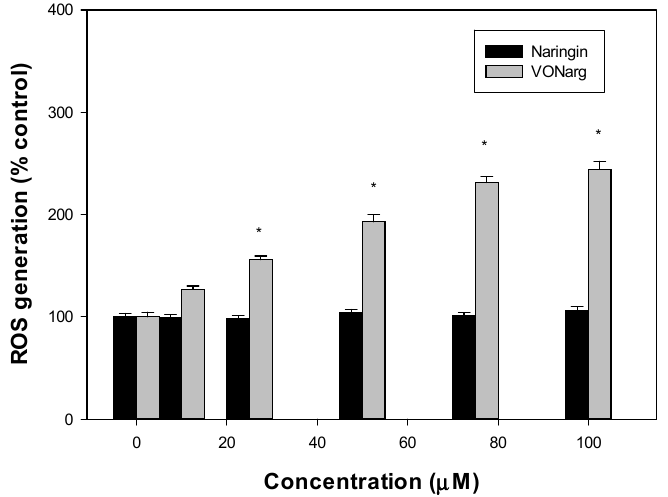
Figure 6. Effects of naringin (black) and VONarg (grey) on H 2 DCFDA oxidation to DCF. A549 cells were incubated at 37 °C in the presence of 10 μ M H 2 DCFDA. The values are expressed as the percentage of the control level and represent the mean ± SEM. * significant difference with control at the 0.05 level.